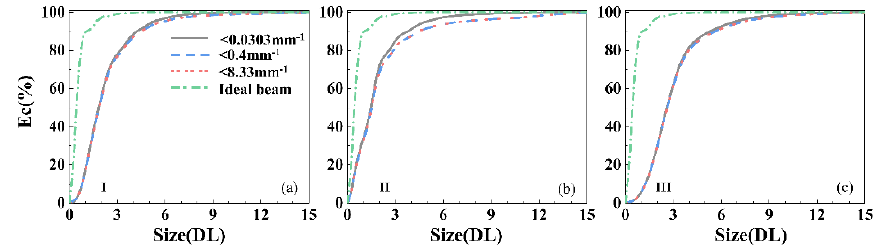
Figure 6. Ec of focal spots when the unfiltered wavefront PV = 2 λ and the PV value ratio of each filtered wavefront is maintained. ( a – c ) are the Ec of type I, II, and III, respectively.